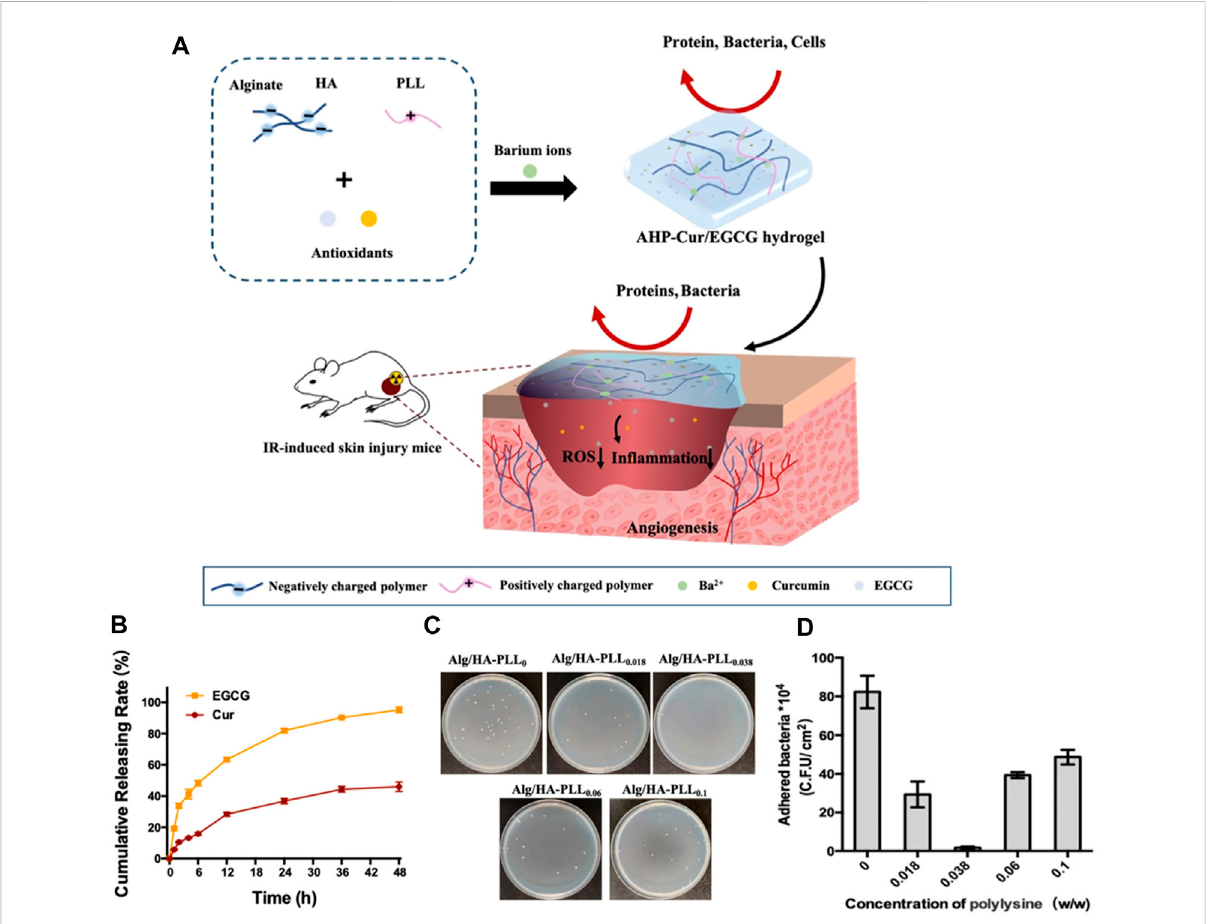
FIGURE 2 Abalancedchargedhydrogel withanti-biofouling andantioxidantproperties for treatment ofirradiation-induced skininjury. (A) The schematic of the one-step preparation of the antioxidants (Curcumin and EGCG) loaded balanced charged hydrogel and its application as the pro-healing wound dressing for the treatment of radiation-induced skin injury in mice. (B) The releasing behavior of curcumin and EGCG from the hydrogel. (C) Digital images of relative E. coli adhesion on the surfaces of different charged hydrogel samples. (D) The Colony-Forming Units of E. coli adhesion on different hydrogel samples,